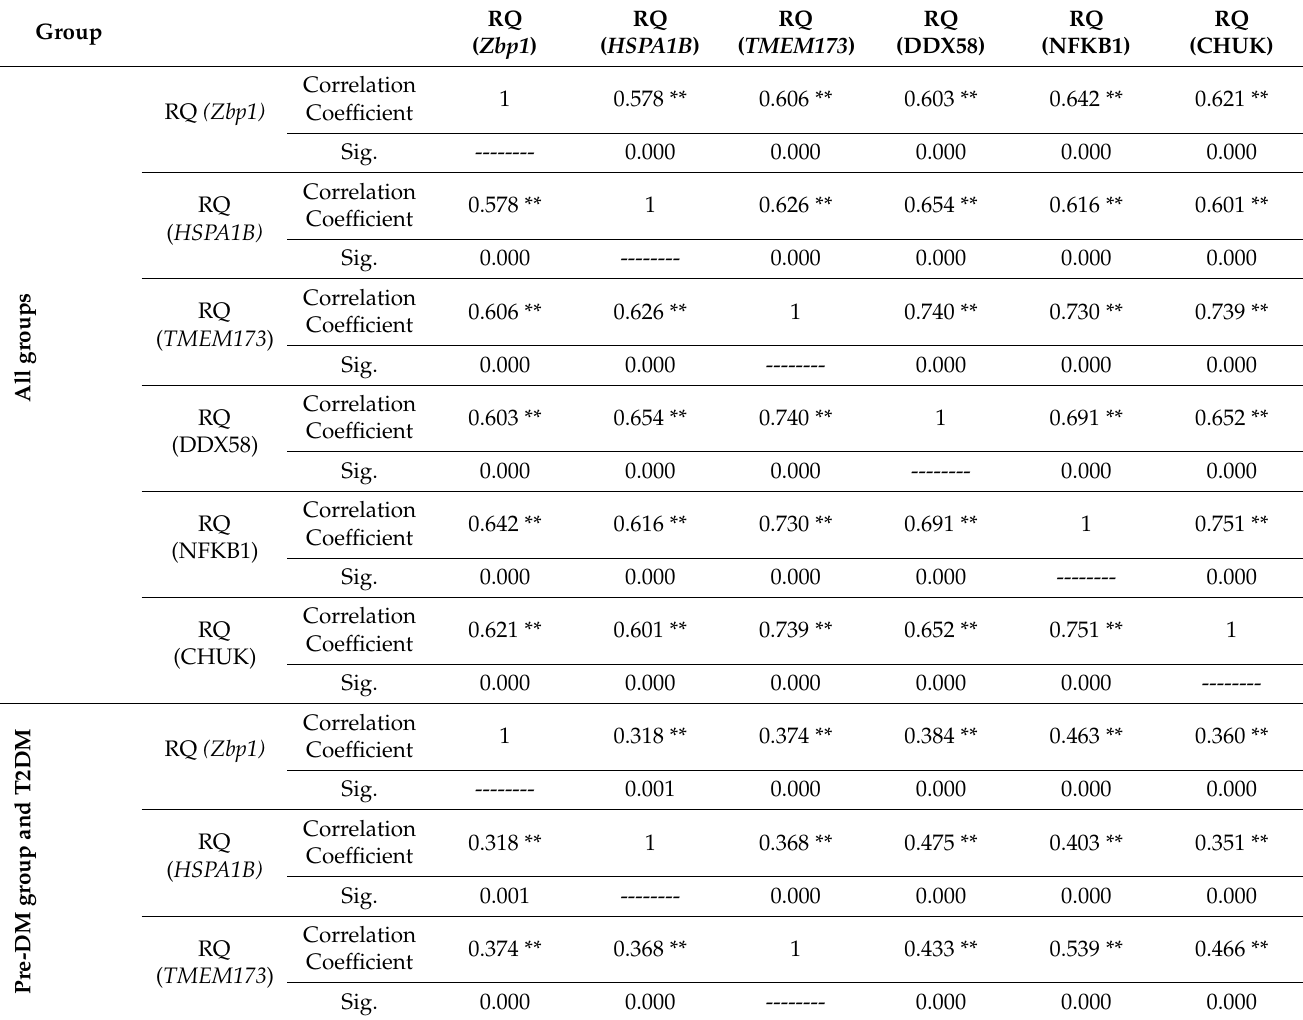
Table 4. Correlation analysis between the 6 mRNAs among all the studied groups and also among the group with pre-DM and the T2DM